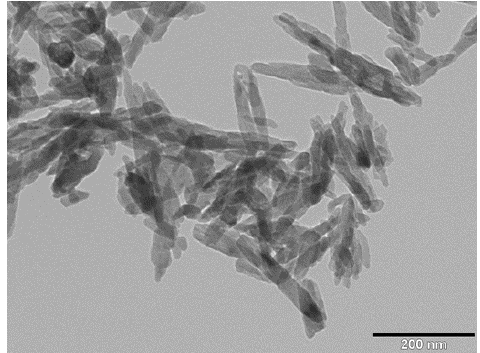
Figure 2. TEM image of nanohydroxyapatite rod (nHA).